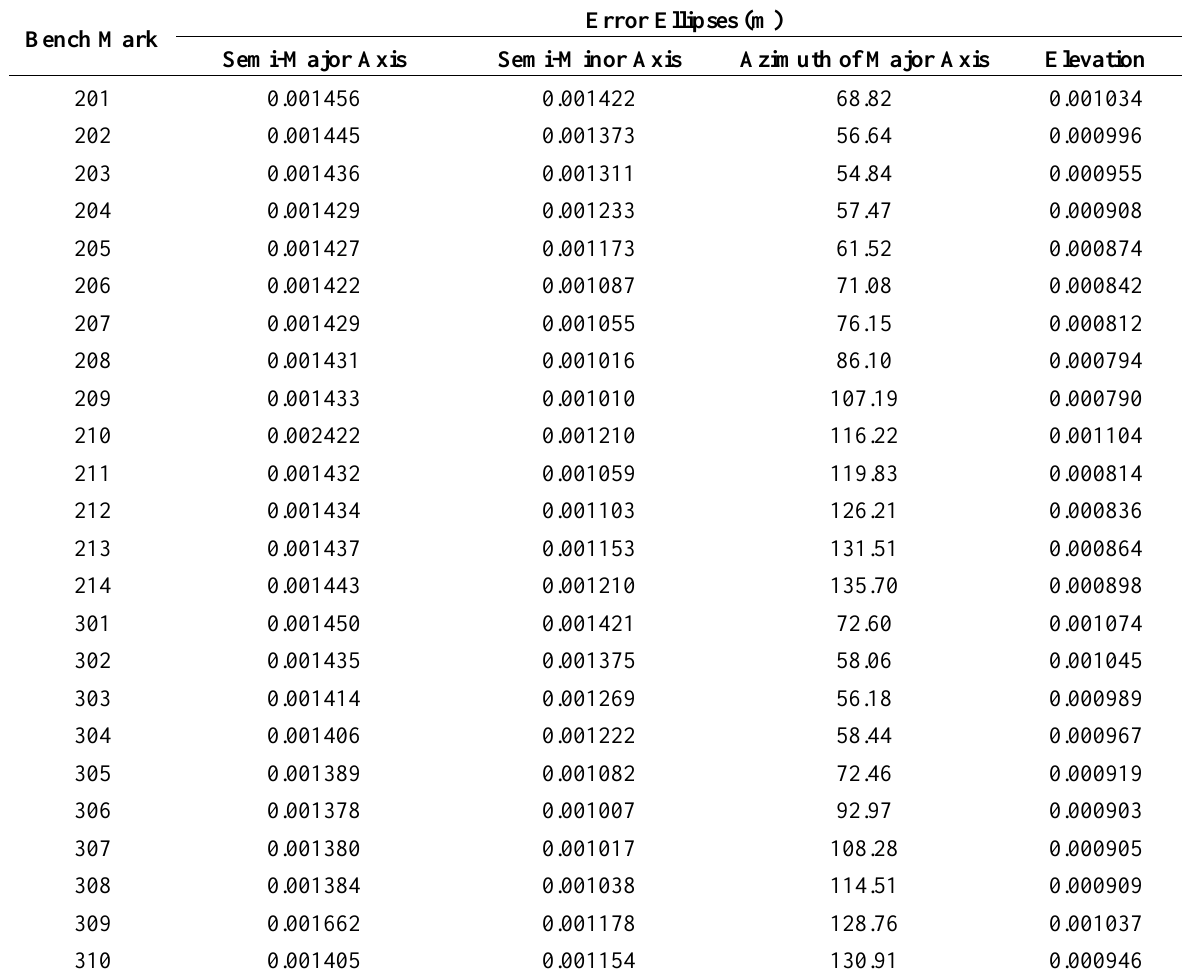
Table 4. Error ellipses of the points of detail detected on the Palazzo del Capitano façade. Data refer to October 2011 in new 3D coordinate